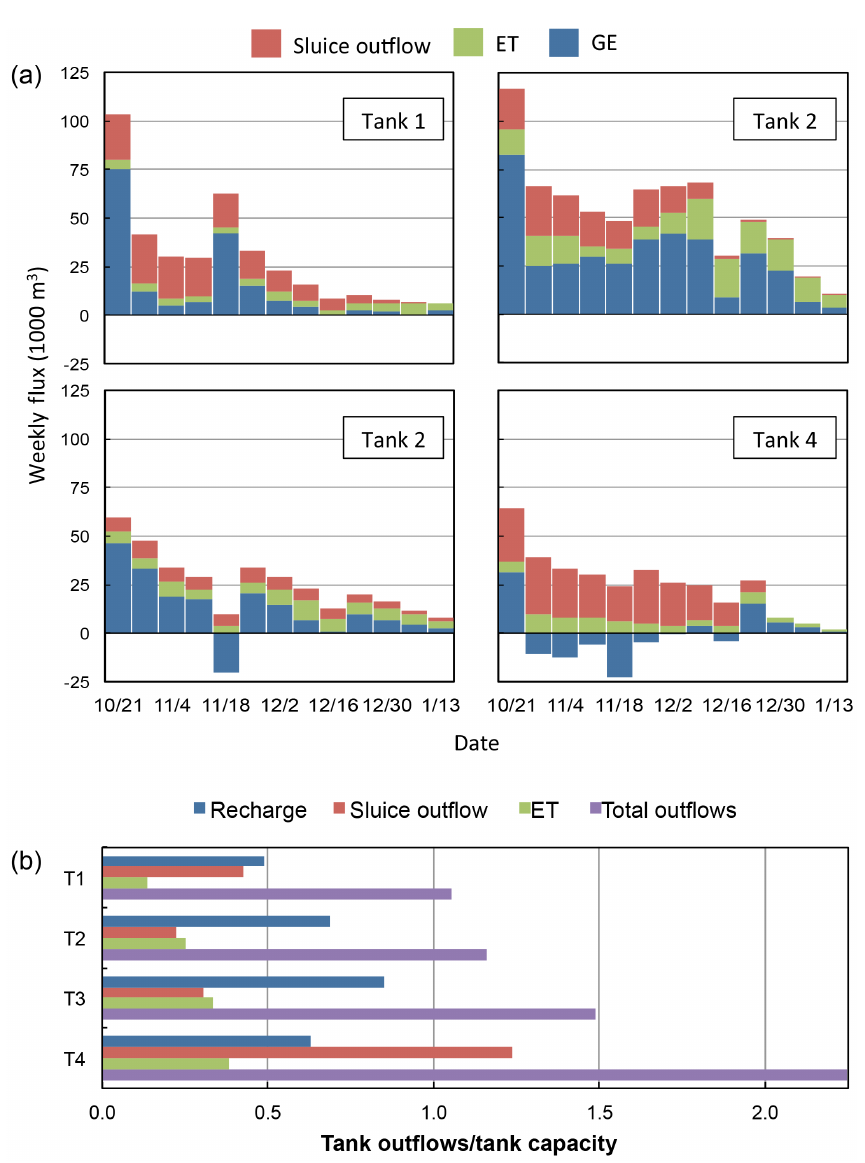
Figure 10. (a) Tank outflow dynamics (ET in green, sluice outflow in red, and GE in blue) shown as weekly integrated volumes for all four tanks. (b) Tank water outflows as a fraction of the tank capacity, with total outflows calculated as the sum of ET, S 0 , and groundwater recharge. The outflow-to-capacity ratios increase down the cascade, such that total outflows for Tank 4 over the study period are more than double the total tank